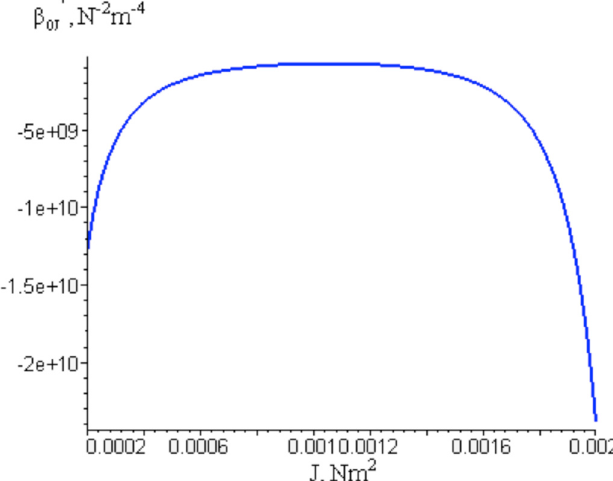
Fig. 6. The speed of change of the impact coef fi cient of the impact value J on the output value.